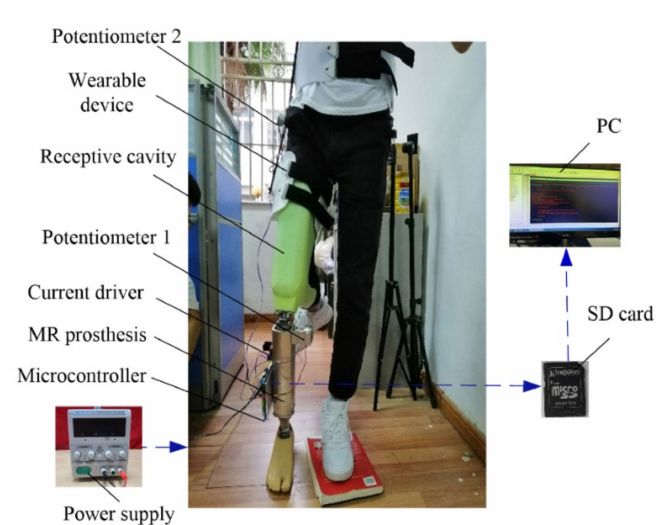
Figure 17. MR prosthesis control system.